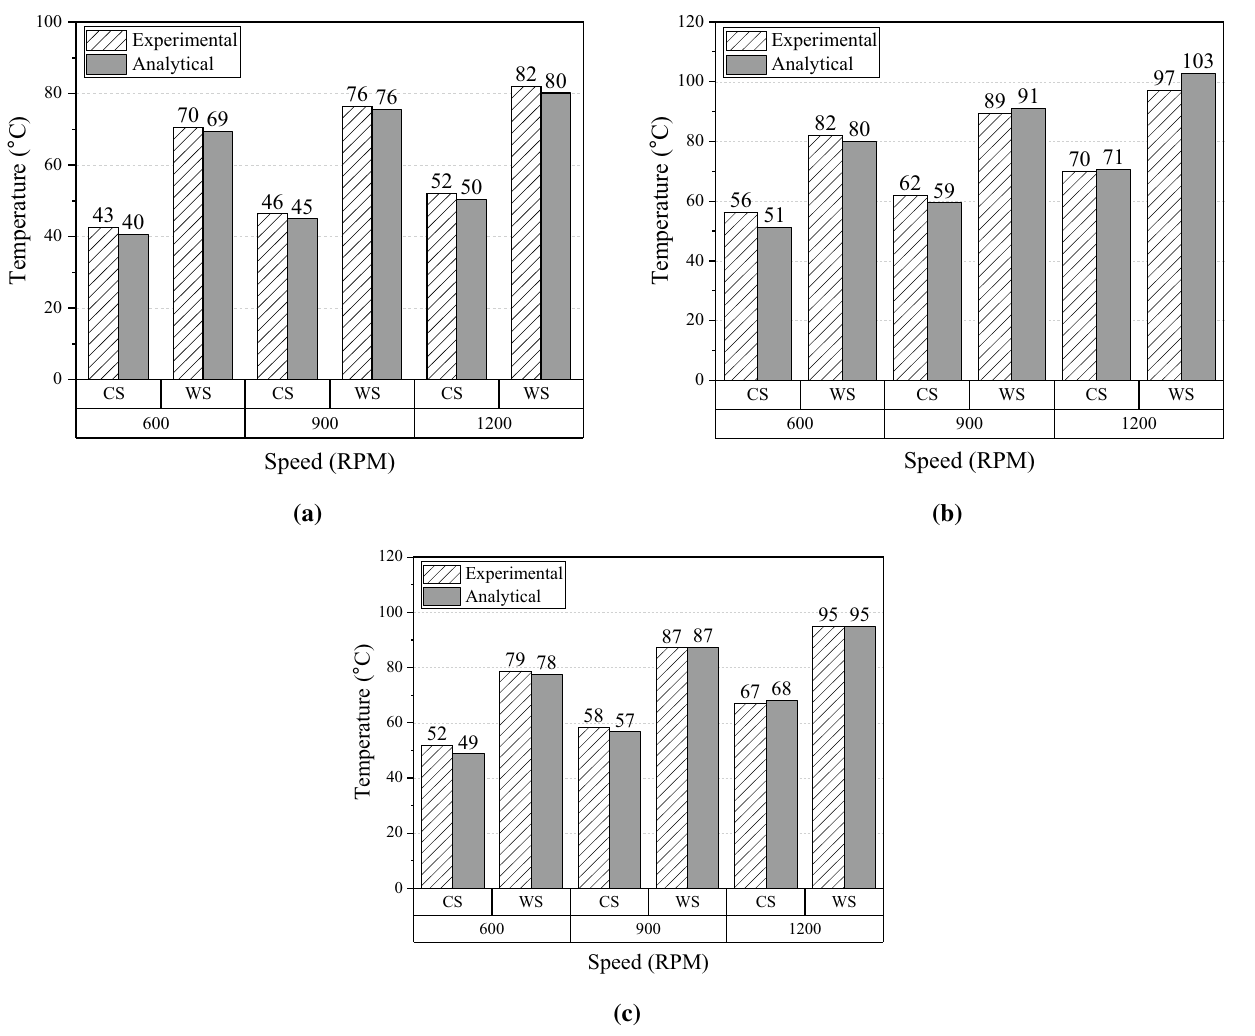
Figure 13. Temperature comparisons at different locations under various speeds and CS and WS ambient conditions when a transmitted torque of 12 N ⋅ m is applied. ( a ) DR pulley surface at outer radii. ( b ) DN pulley surface at outer radii. ( c ) Belt surface.